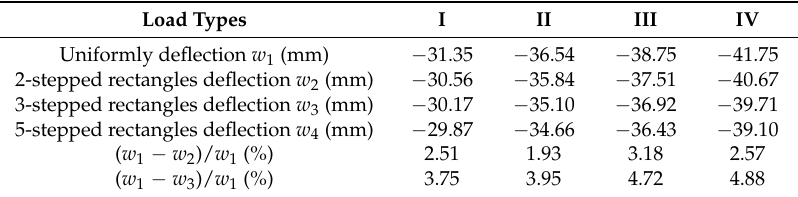
Table 5. Comparison of maximum deflection under four load